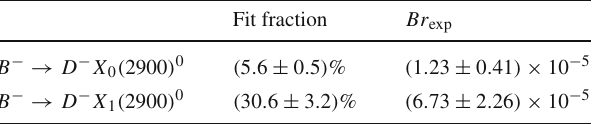
Table 1 The fit fractions of B − → D − X 0 , 1 ( 2900 ) in B − →